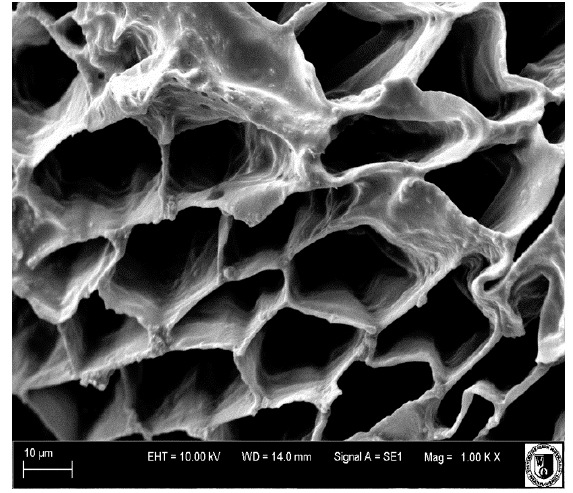
Figure 8. SEM (Scanning Electron Microscope) picture of beetroot sample dehydrated in concentrated chokeberry juice and VMFD at 480 W (1000× magnification).